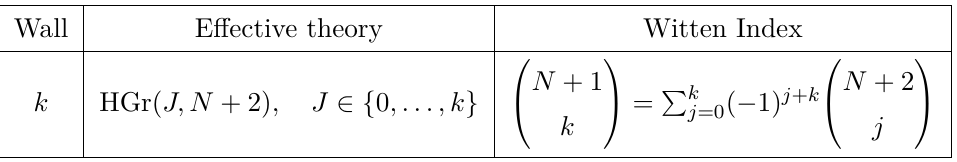
Figure 4 . Examples of 1-wall solutions of Sp(3) , F = 5 .